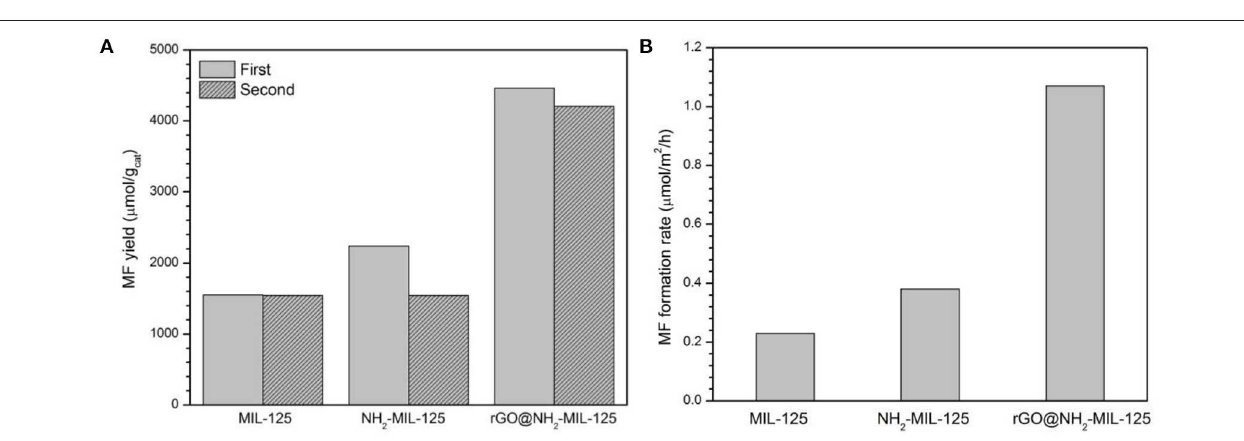
1,116 µ mol · g − 1 · h − 1 and more than twice that of pure